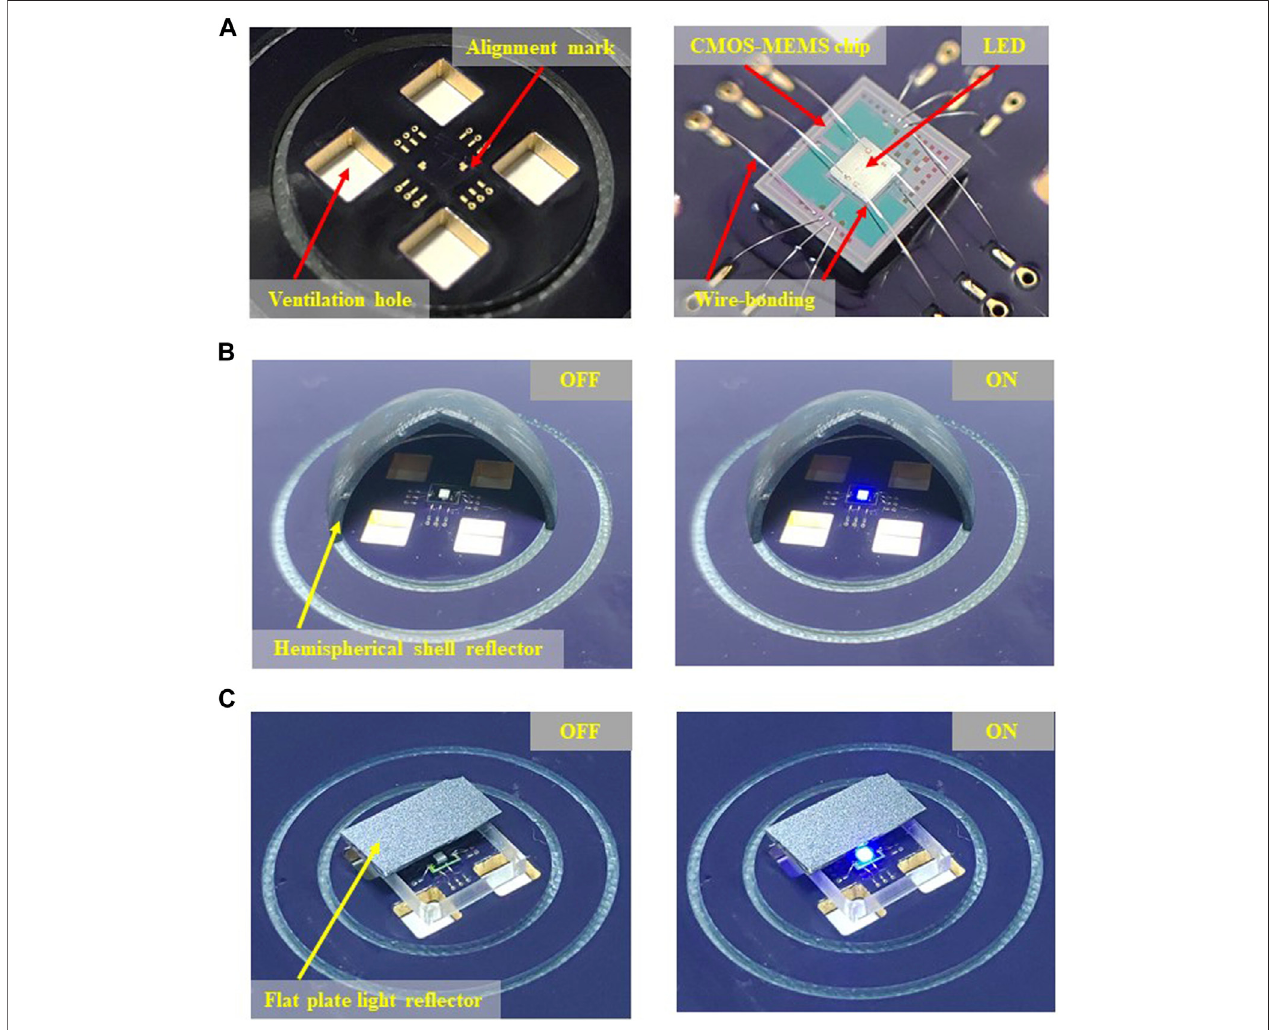
FIGURE 5 | (A) Typical fabrication results of the gas sensor before/after wire bonding and assembly on the PCB, with the circular groove designed to align and mount the hemispherical shell re fl ector, (B) lighting test on the gas sensor with the hemispherical shell re fl ector, and (C) lighting test on the gas sensor with the fl at plate re fl